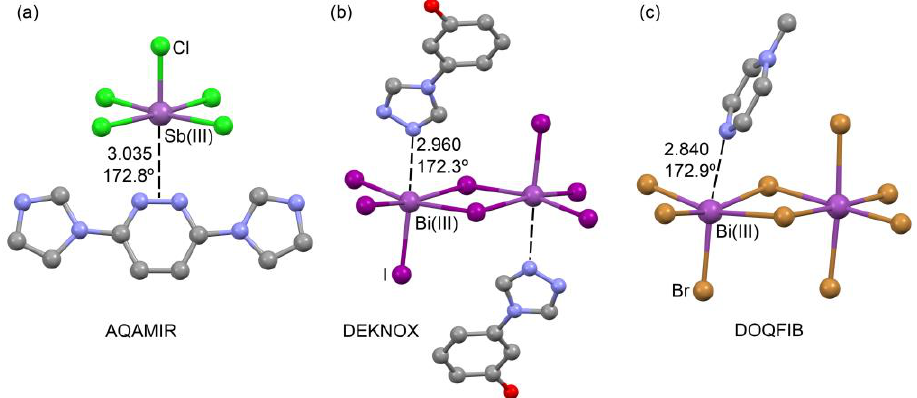
Figure 3. X-ray structures of AQAMIR ( a ), DEKNOX ( b ) and DOQFIB ( c ). H-atoms omitted. Distances are given in Å. Color code: Carbon grey, chlorine green, antimony and bismuth violet, bromine bronze, oxygen red, nitrogen blue, iodine purple.